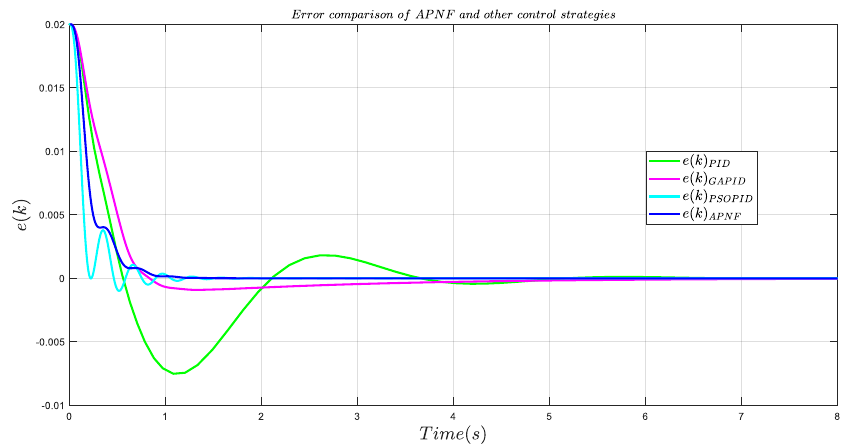
Figure 9. Response performance error comparison curves of the four control systems. Table 2. Comparison of five control methods of Table 1. Parameters involved in APNF model.